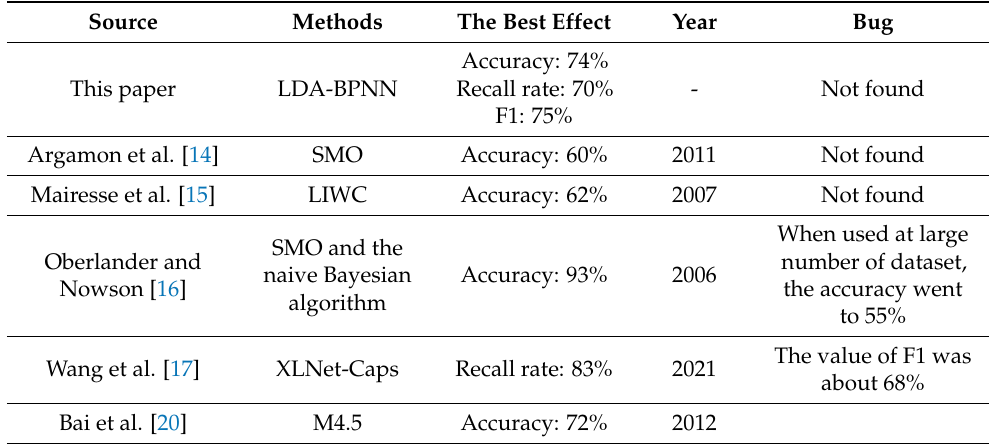
Table 1. Comparison of 6 different